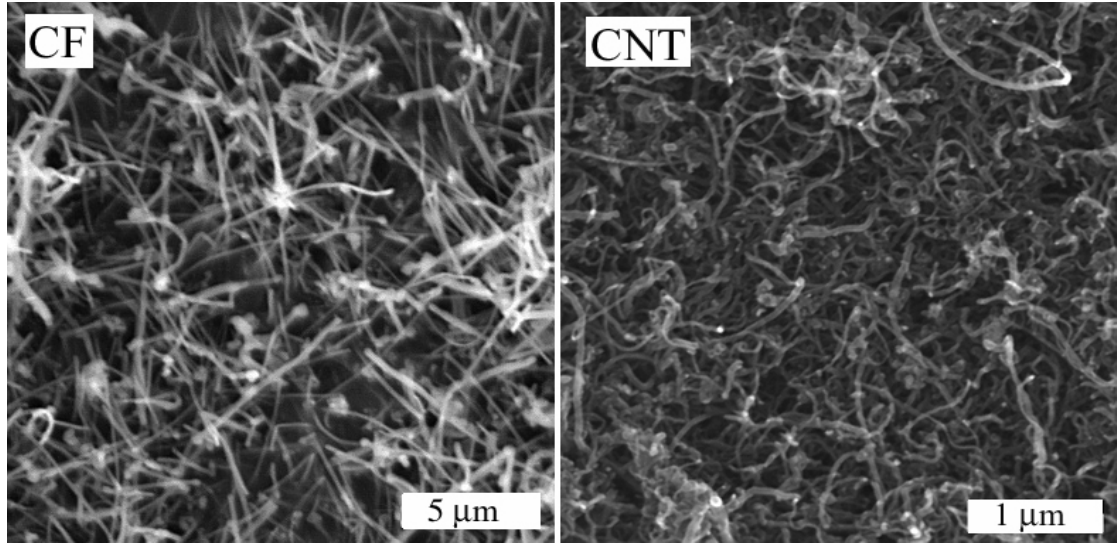
Figure 1. Scanning Electronic Microscopy images of used fillers: carbon fibers (CFs) and carbon nanotubes